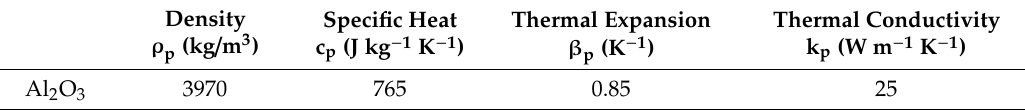
Table 2. Thermophysical properties of Al 2 O 3 nanoparticles [82].